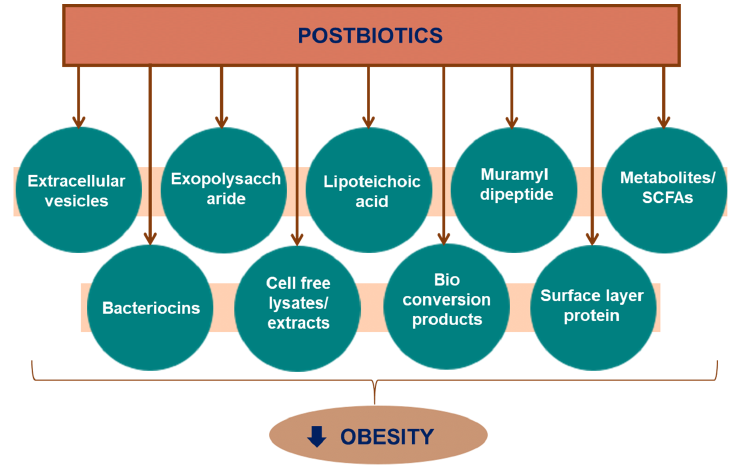
Figure 1. The present fi gure highlights di ff erent postbiotics evaluated against obesity. ↓ =